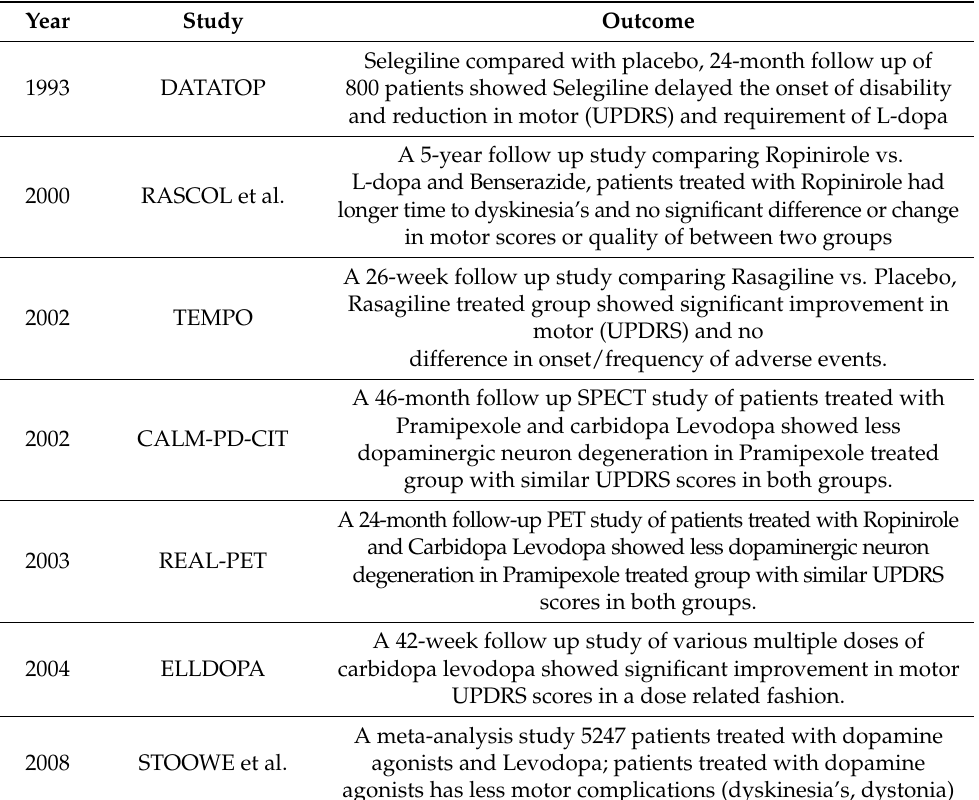
Table 3. Studies showing clinical benefits of early diagnosis of Parkinson’s